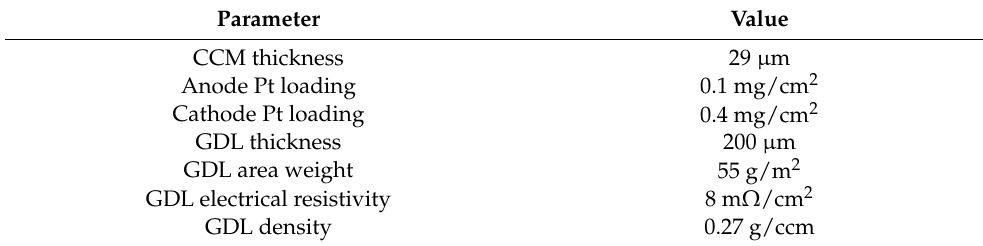
Table 2. Parameters of the material of open-cathode